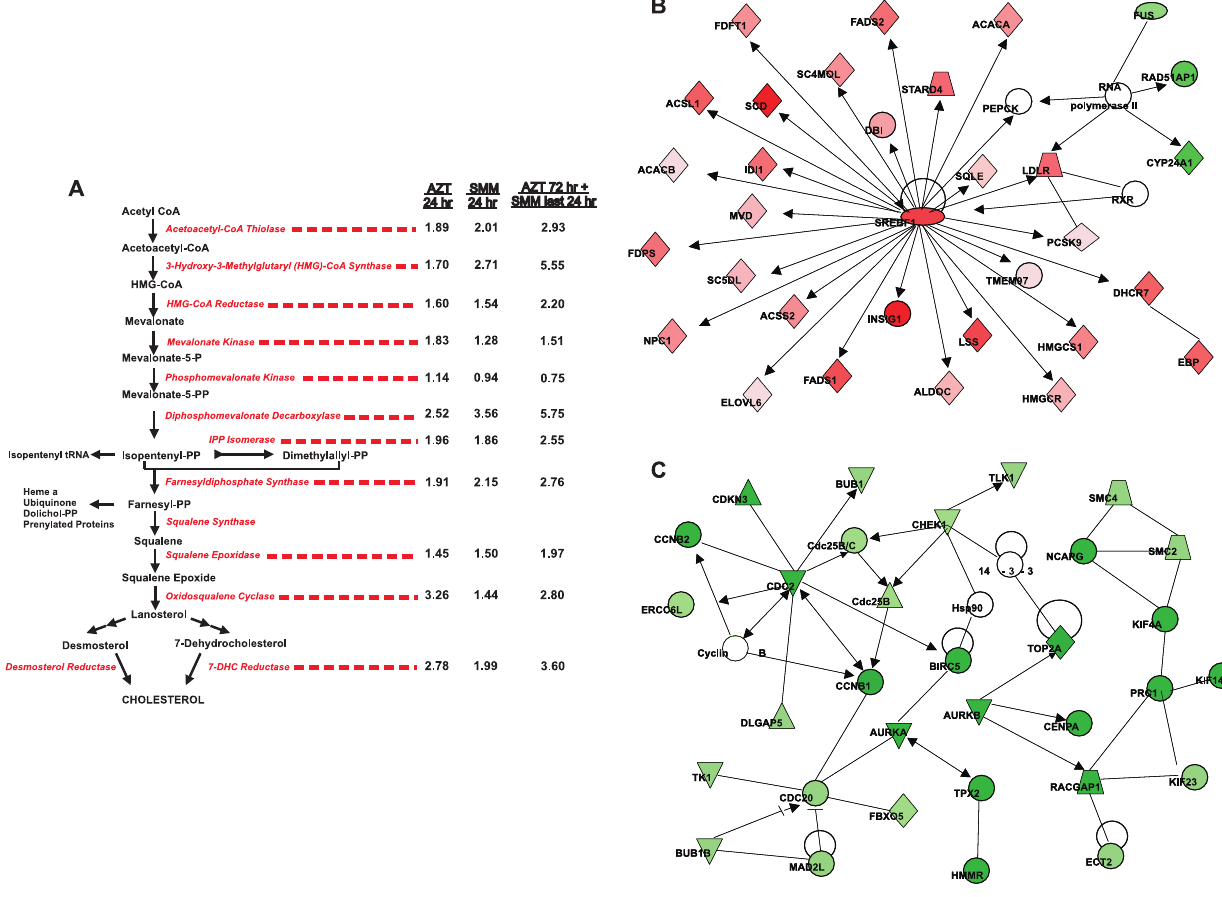
Figure 4. AZT up-regulates lipid/cholesterol metabolism and down-regulates cell cycle genes. A: The cholesterol biosynthetic pathway and the fold-changes induced for each of the enzymes within the pathway are indicated. Data are expressed as fold changes in gene expression values from 24 hr AZT vs. 24 hr PBS (left numbers), 24 hr SMM vs. 24 hr PBS (center numbers) and 72 hr AZT ( + addition of mucosal SMM during the last 24 hr) vs. 24 hr PBS (right numbers). Both SMM and AZT increased the enzymes involved in the cholesterol biosynthetic pathway, and their effect appears to be additive. B and C: Ingenuity Pathways Analysis TM was used to generate two top significant networks for genes regulated by AZT 24 hr vs. PBS 24 hr. The top two networks are shown. The analysis settings were as follows: only direct relationships were considered, endogenous chemicals were excluded, and only relationships where data sources=Argonaute 2 or Ingenuity curated findings were considered. The network depicted in B was labeled ‘‘Lipid Metabolism, Small Molecule Biochemistry, Nucleic Acid Metabolism’’ and had a score=47. The network depicted in C was labeled ‘‘Cancer, Cell Cycle, Reproductive System Disease’’ and had a score=44. Red indicates up-regulation. Green indicates down-regulation.